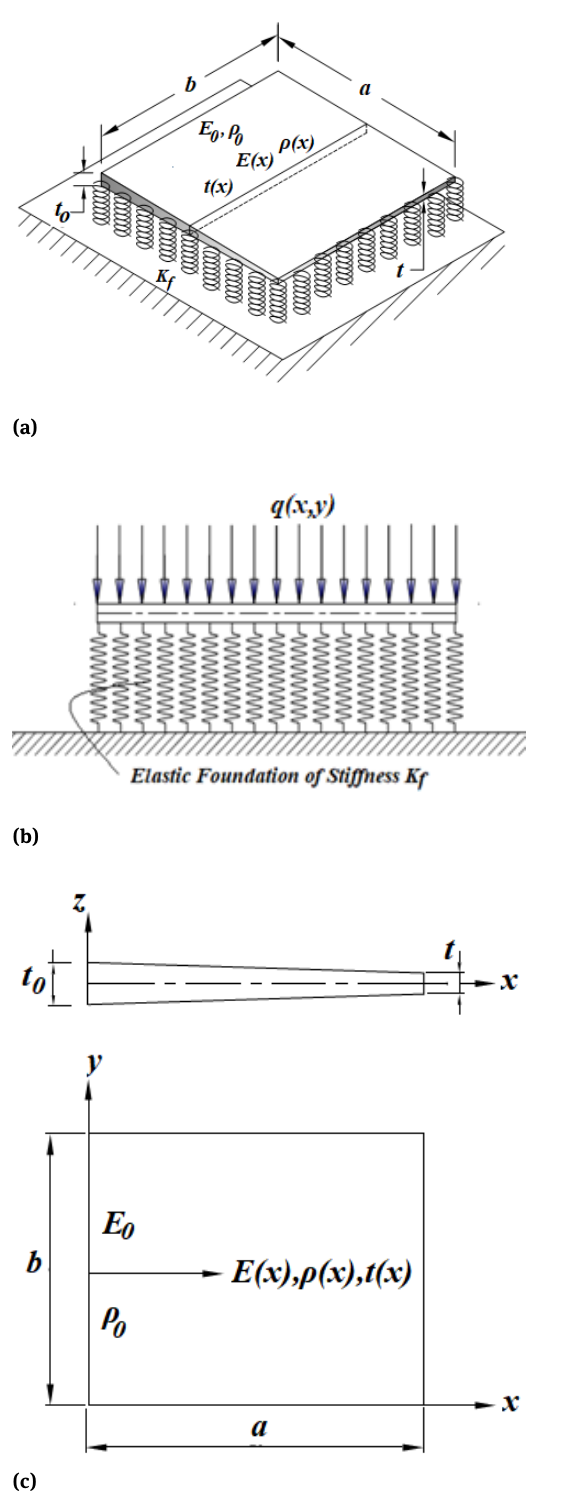
Figure 1: (a) Plate on Elastic Foundation, (b) Loading and Elastic Foundation and(c) Front and Top view of the Tapered